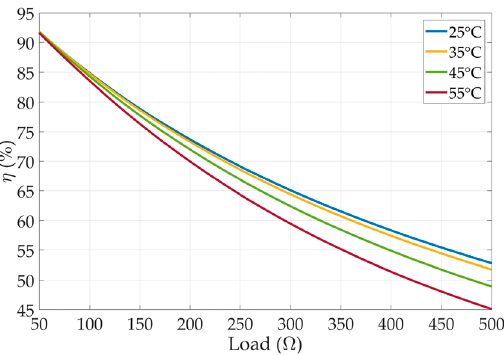
Figure 14. The variation in the efficiencies in different loads at different temperatures. The bifurcation of the LCC-S resonant wireless power transfer system is analyzed according to the papers [19,20].